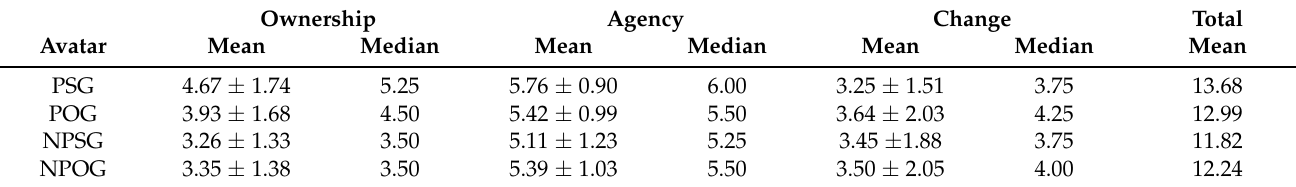
Table 2. Virtual Embodiment Questionnaire results (both